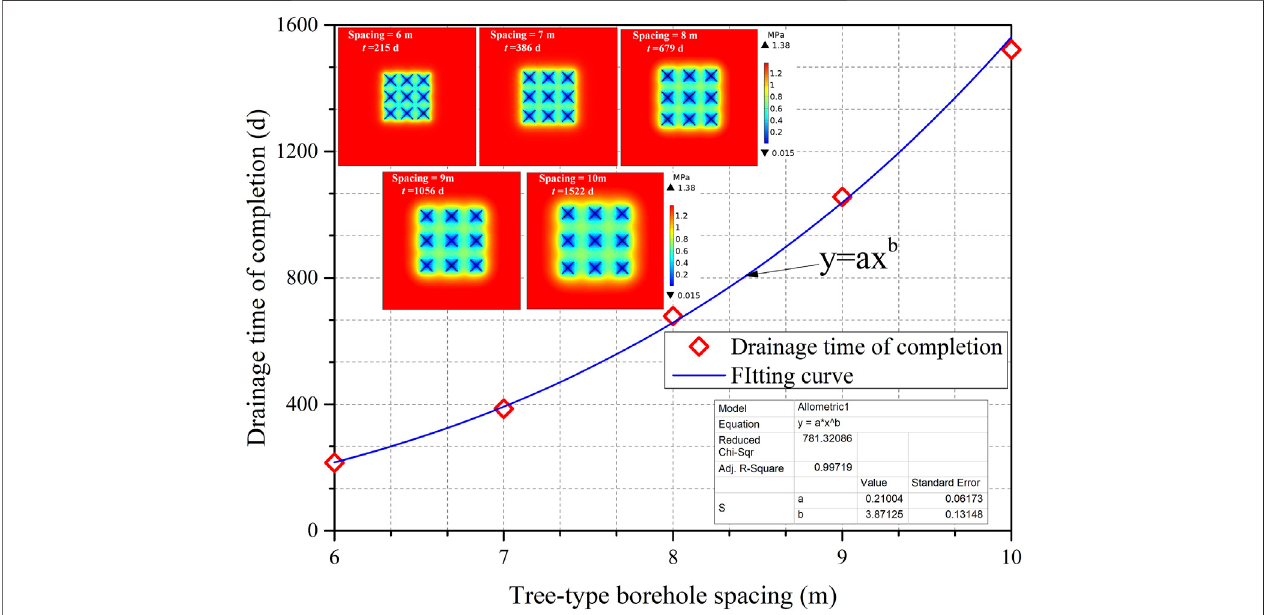
FIGURE 9 | Drainage completion time vs tree-type borehole spacing.